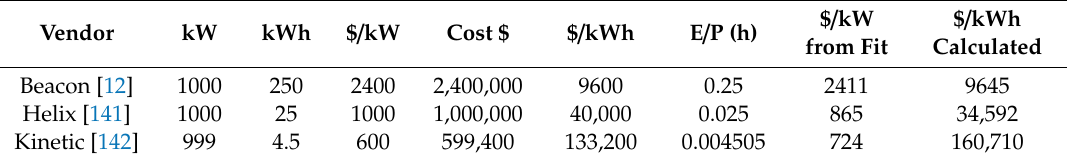
Table 30. Capital cost for various e / p ratios for flywheel